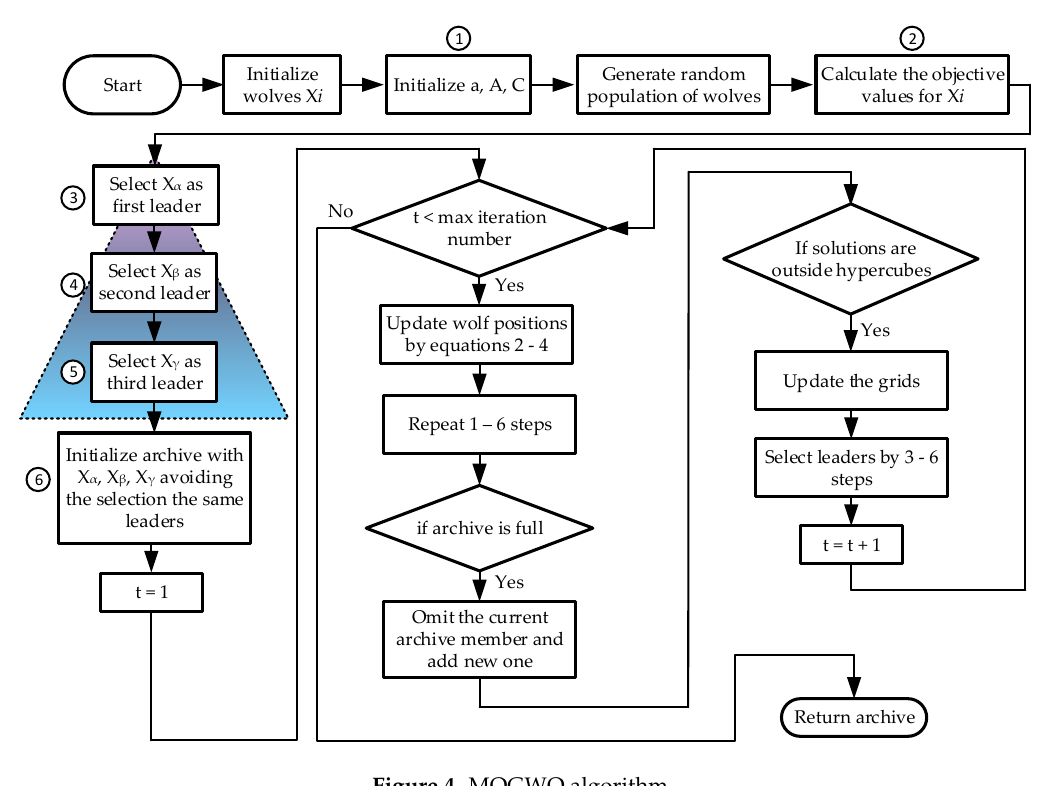
Figure 4. MOGWO algorithm.